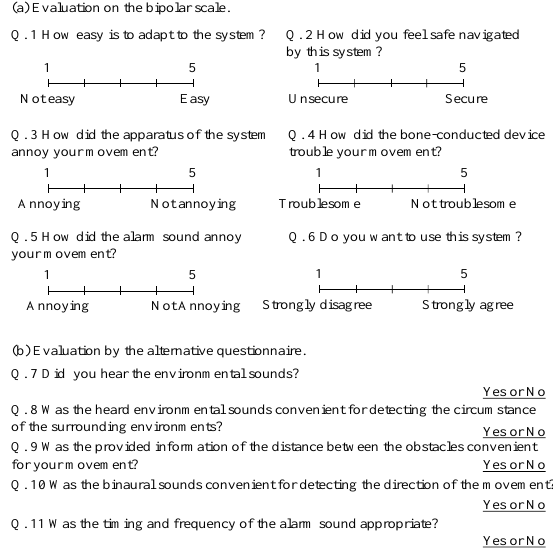
Figure 12. ( a ) Subjective evaluation questionnaire based on a five-category bipolar scale and ( b ) yes/no options.